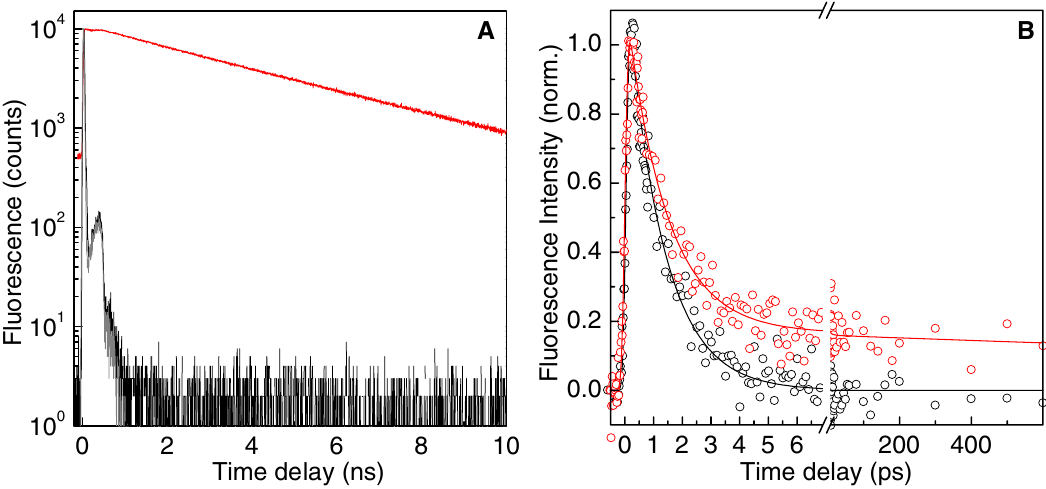
Figure 4. Fluorescence decay probed at 500 nm of DFHBI (2 μM) in absence (black) and presence (red) of bSP (20 μM) under flow cell conditions. (A) Time Correlated Single PhotonCounting (TCSPC) measurements of the free dye (black) in solution excited at 416 nm and ofthe complex excited at 470 nm (red), excitation power 10 μW.The fluorescence decay of thefree dye follows the instrument function IRF and is resolved in Fig. 4B. (B) Fluorescence up-conversionmeasurements of the free DFHBI (black) and the DFHBI/bSP mixture (red),excitation at 400 nm (25